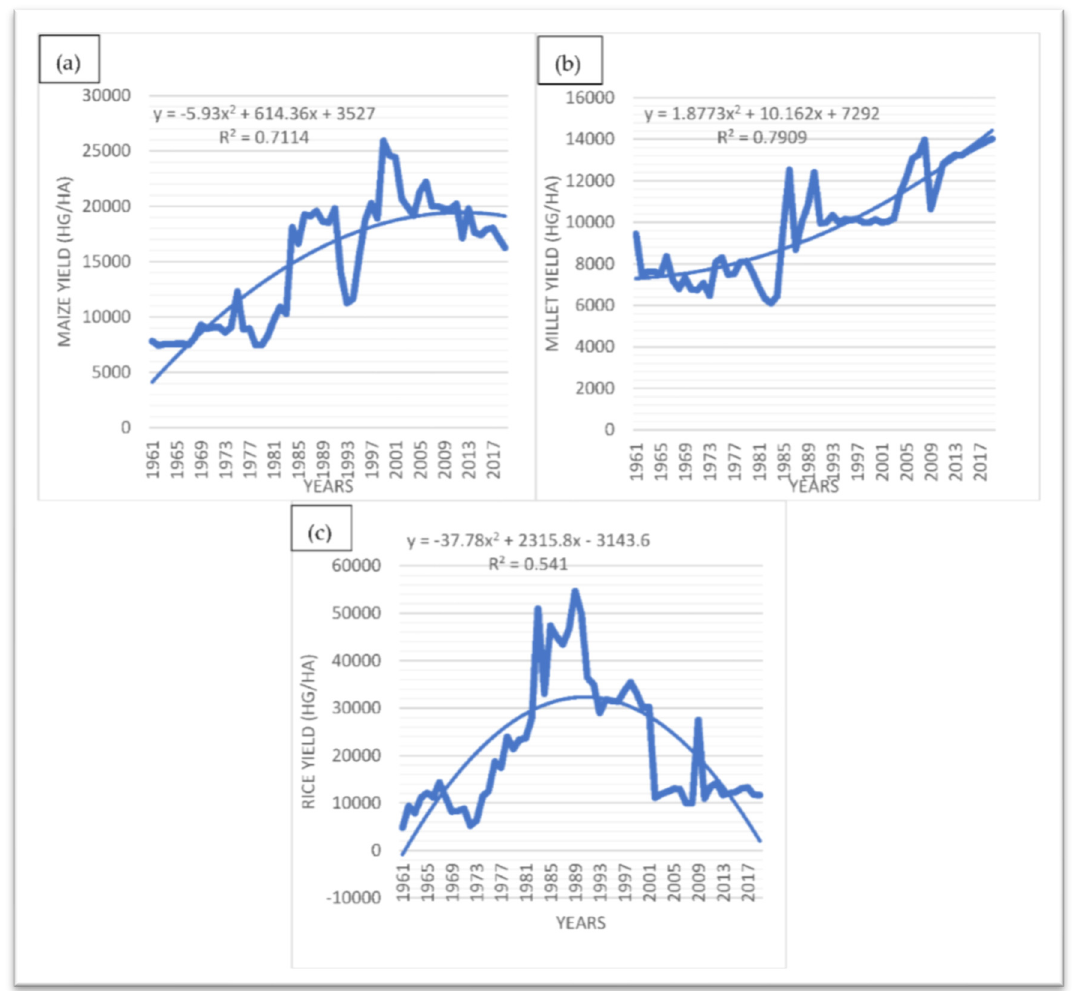
Figure 4. Polynomial regressions at a National Scale for ( a ) Maize ( b ) Millet and ( c ) Rice yield.